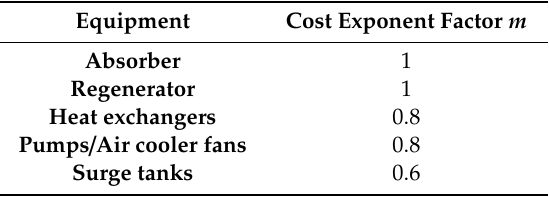
Table 3. The cost exponent factor m for di ff erent equipment in the amine gas plant